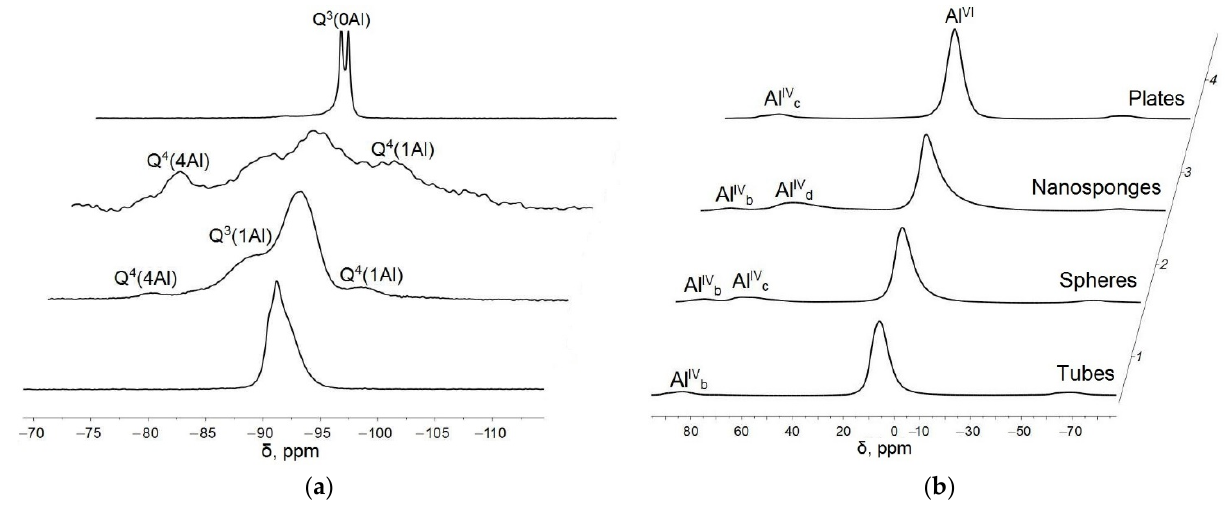
Figure 4. NMR spectrum: ( a )— 29 Si; ( b ) — 27 Al.